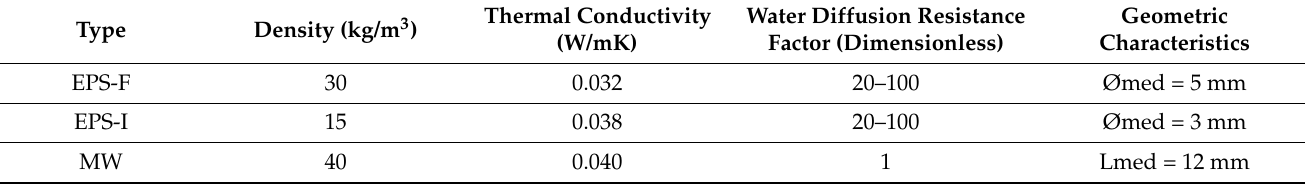
Table 3. Physical characteristics of the insulation waste used (URSA Ibérica Aislantes, S.A., Madrid, Spain).